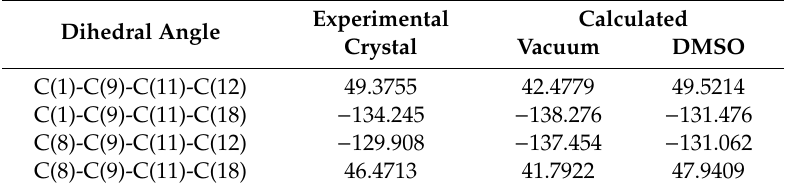
Table 4. Selected dihedral angles (°) for comparison between experimental and calculated values. Dihedral Angle Experimental Dihedral Angle